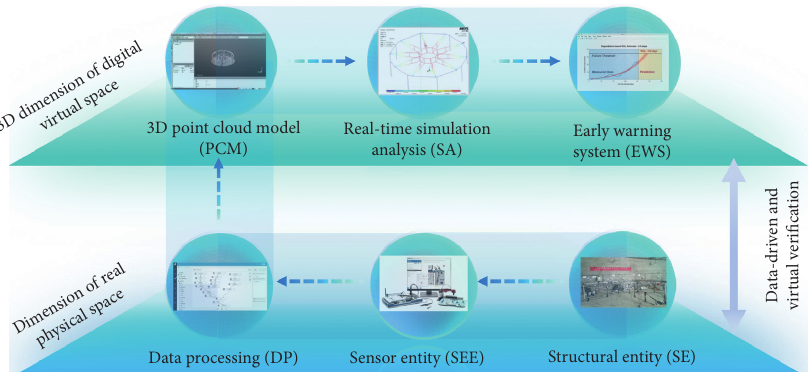
Figure 4: Structural health prediction system framework driven by digital twins.